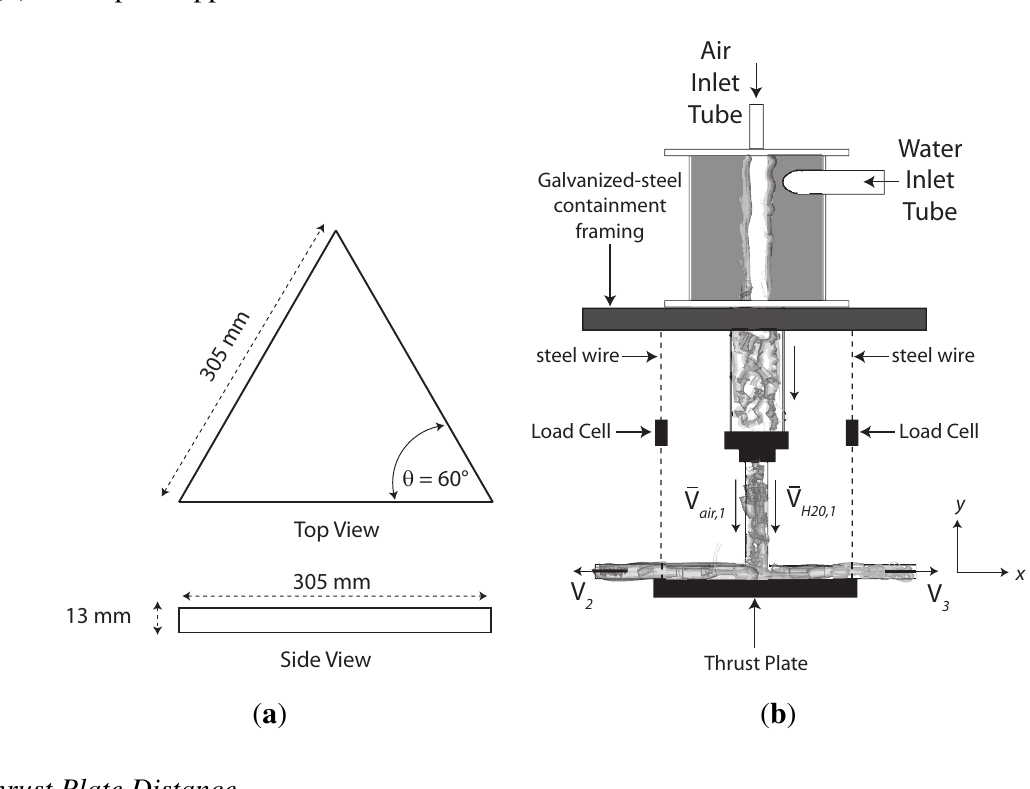
Figure 7. Thrust-plate schematic and experimental location. ( a ) Thrust-plate sketch; ( b ) thrust-plate